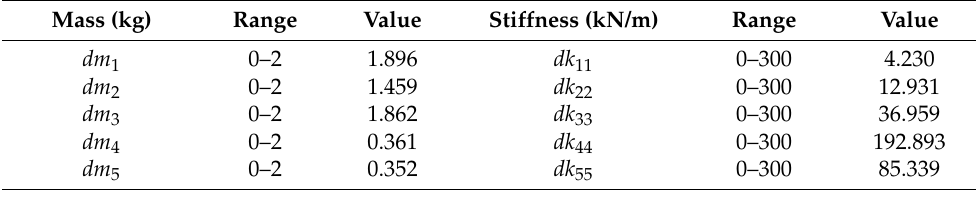
Table 19. Parameters of added mass and stiffness.